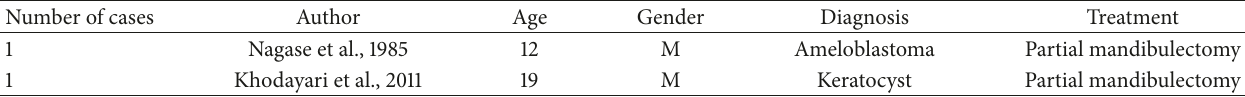
Table 1: Cases of spontaneous condylar reformation reported in the English